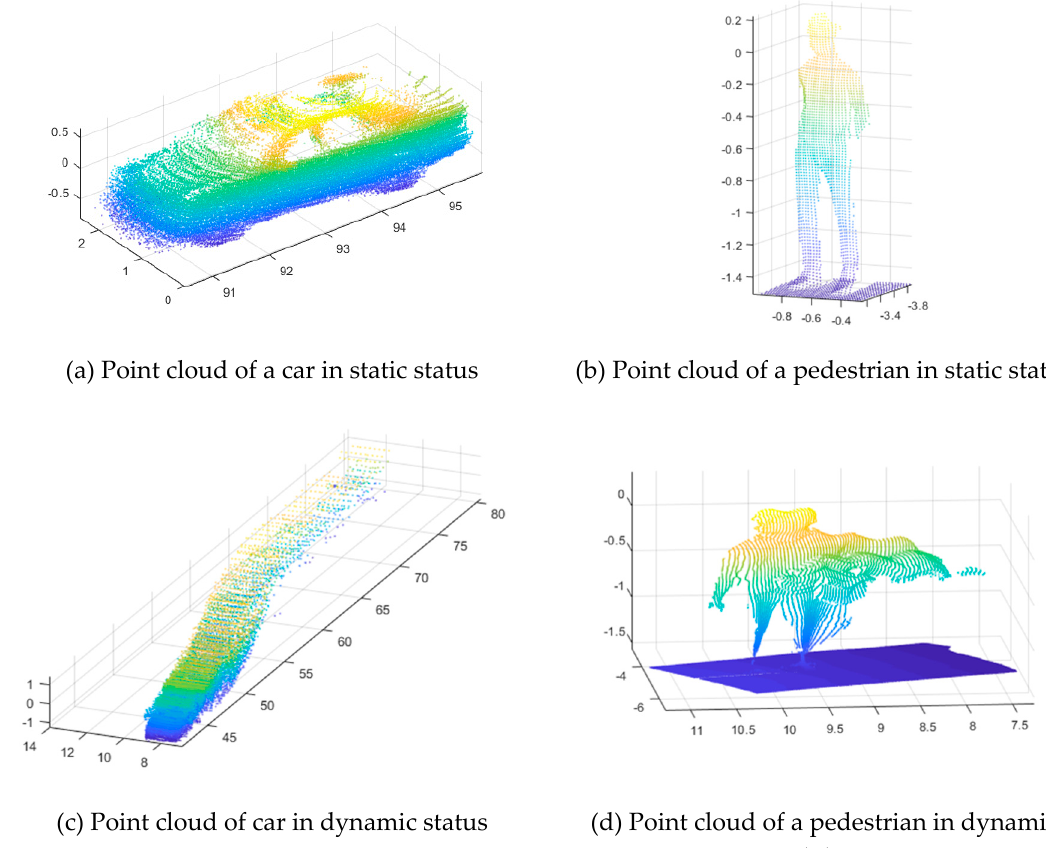
Figure 1. Examples of the distorted shape of clutter objects after data acquisition.